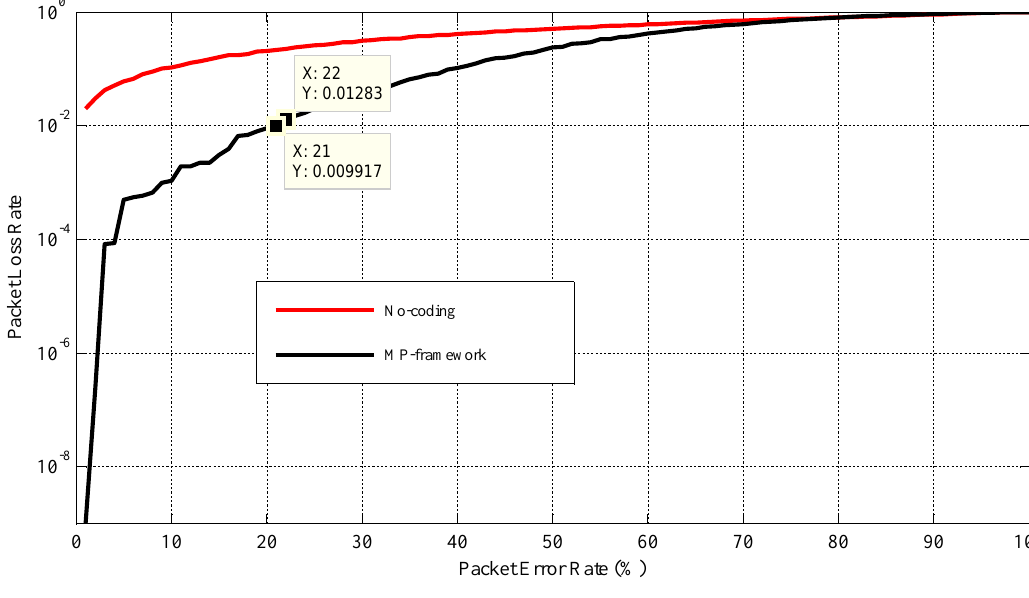
Figure 6. The MP mechanism’s reliability